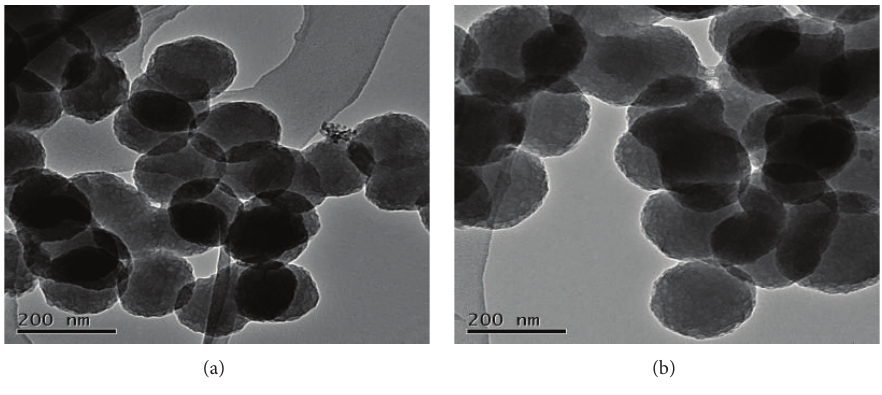
Figure 1: TEM of P(AN-VAc-PMMT) ((a) 2%, (b)